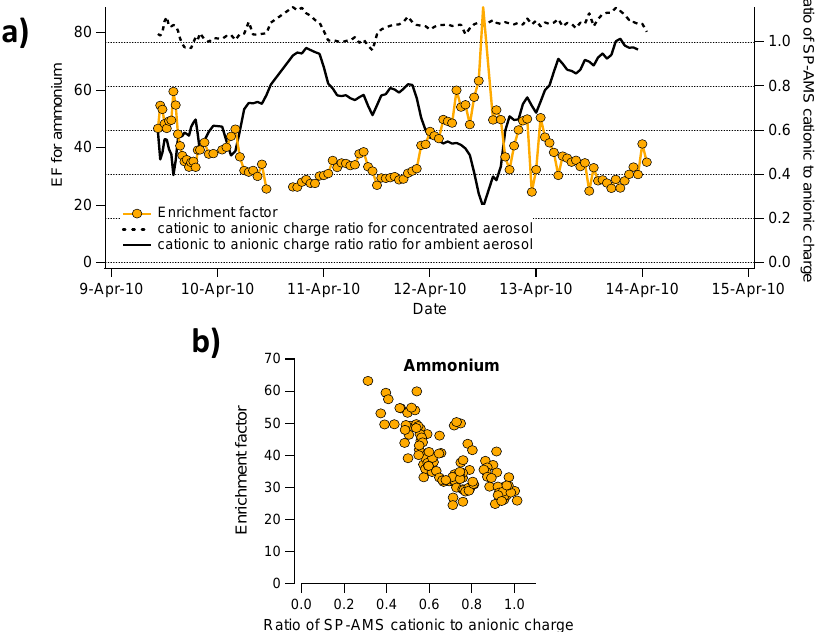
Figure 8. The ratio of SP-AMS cationic to anionic charge for ambient and concentrated aerosol and the enrichment ratio for ammonium (a) , and the correlation between EF and the ratio of SP-AMS cationic to anionic charge for ammonium (b)